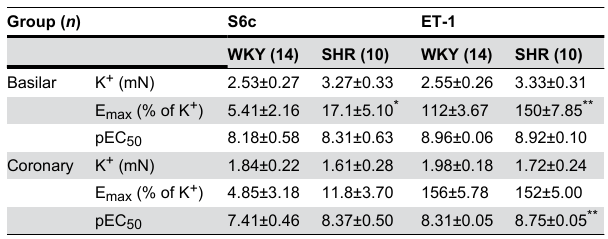
Table 1. E and pEC values of the basilar and coronary max 50 arterial segment concentration-contractile curves isolated from endothelin receptor agonist-induced spontaneously hypertensive